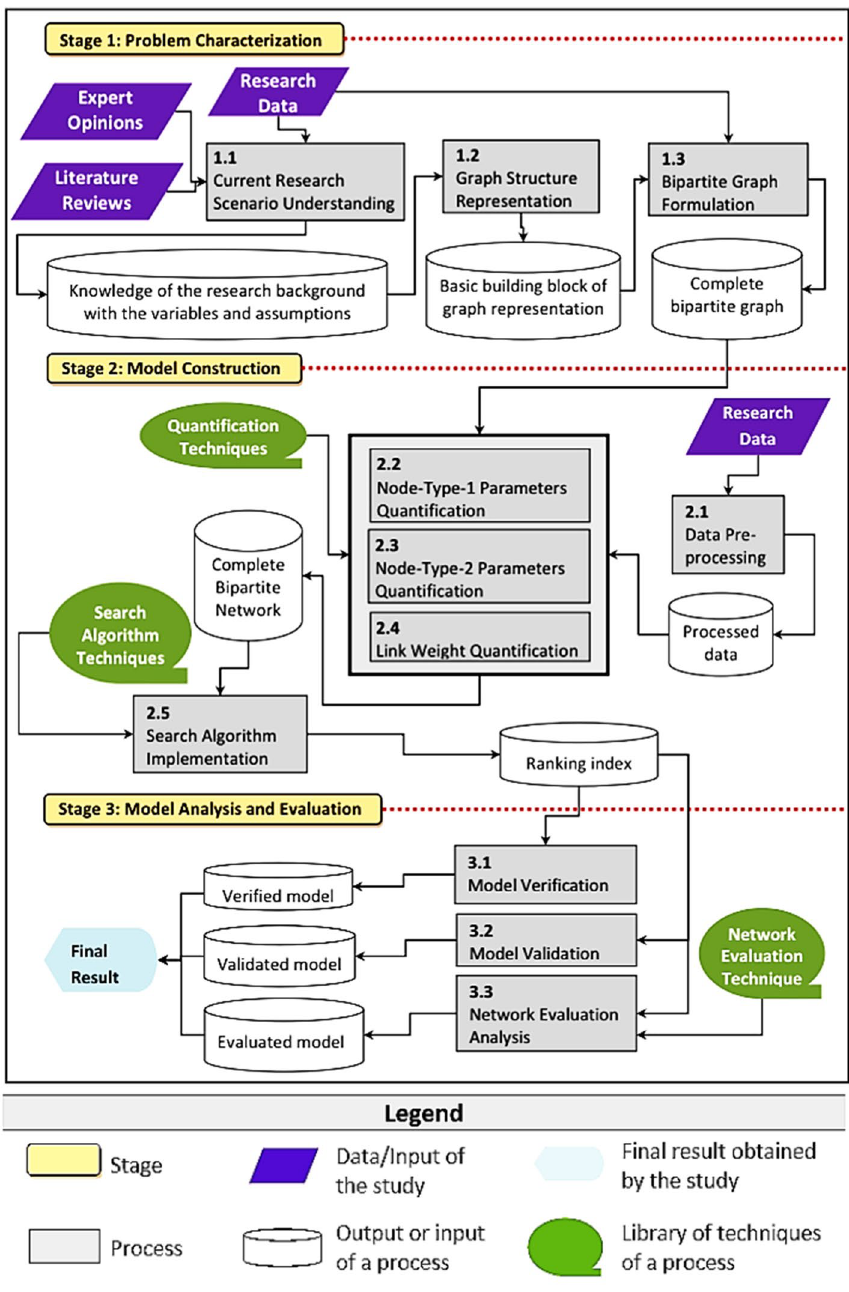
Fig. 1 Bipartite Network Modeling (BNM)